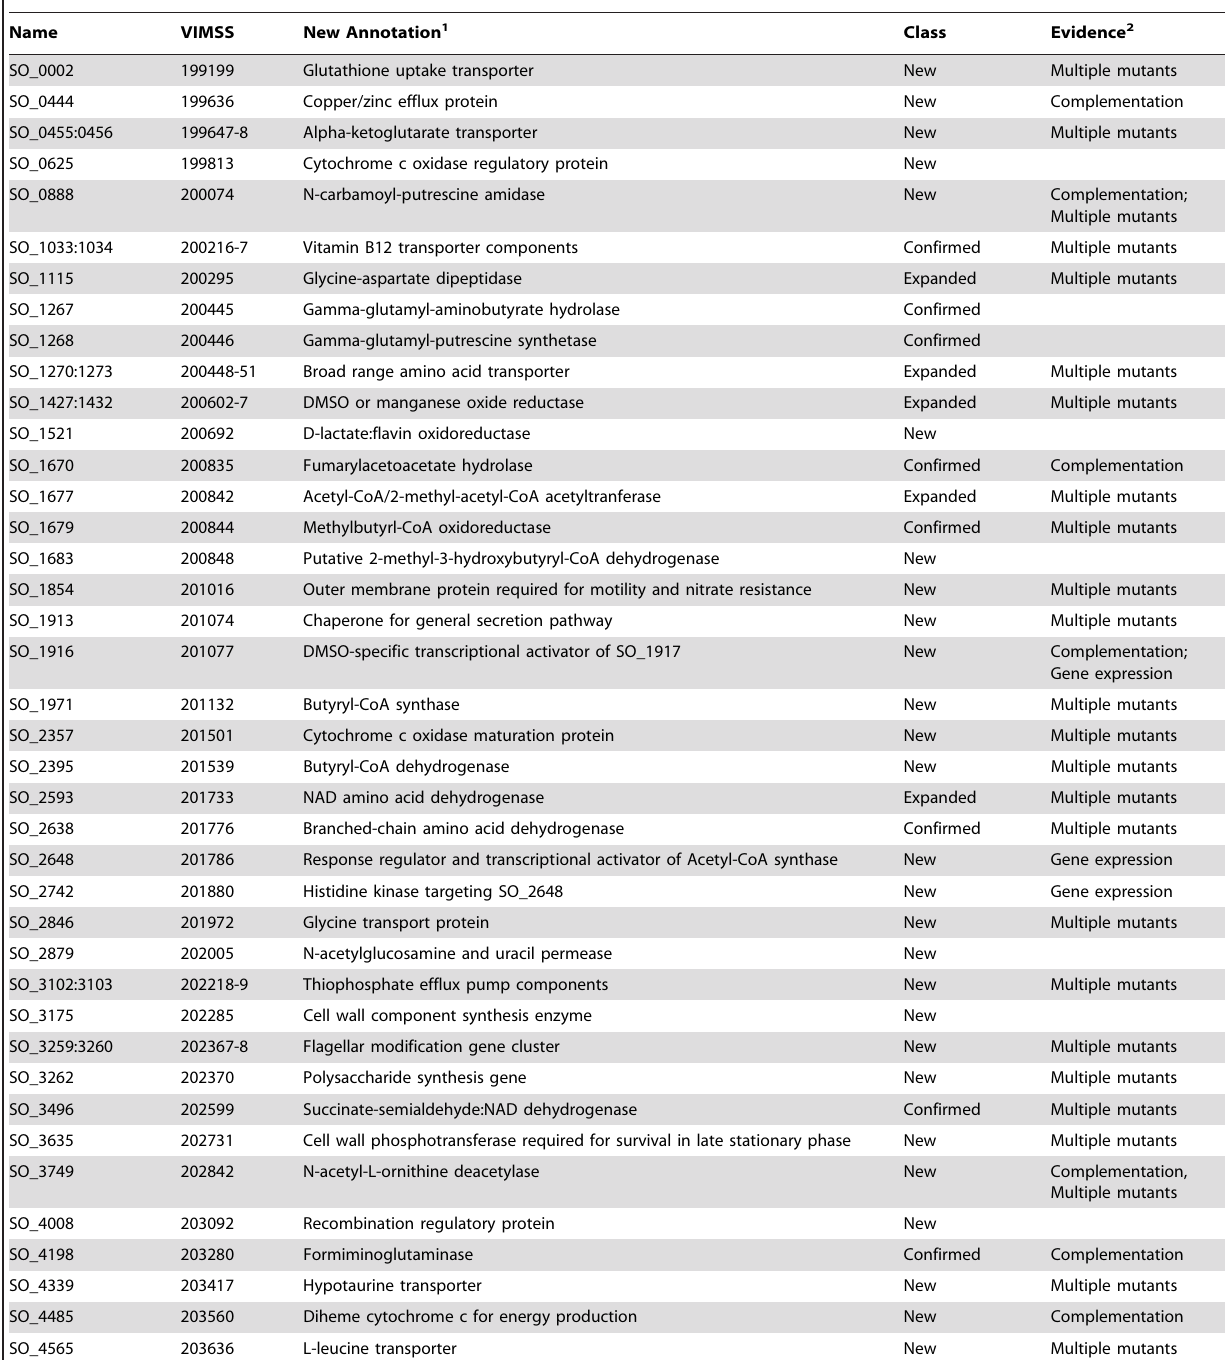
Table 1. New, expanded, and confirmed S. oneidensis MR-1 gene